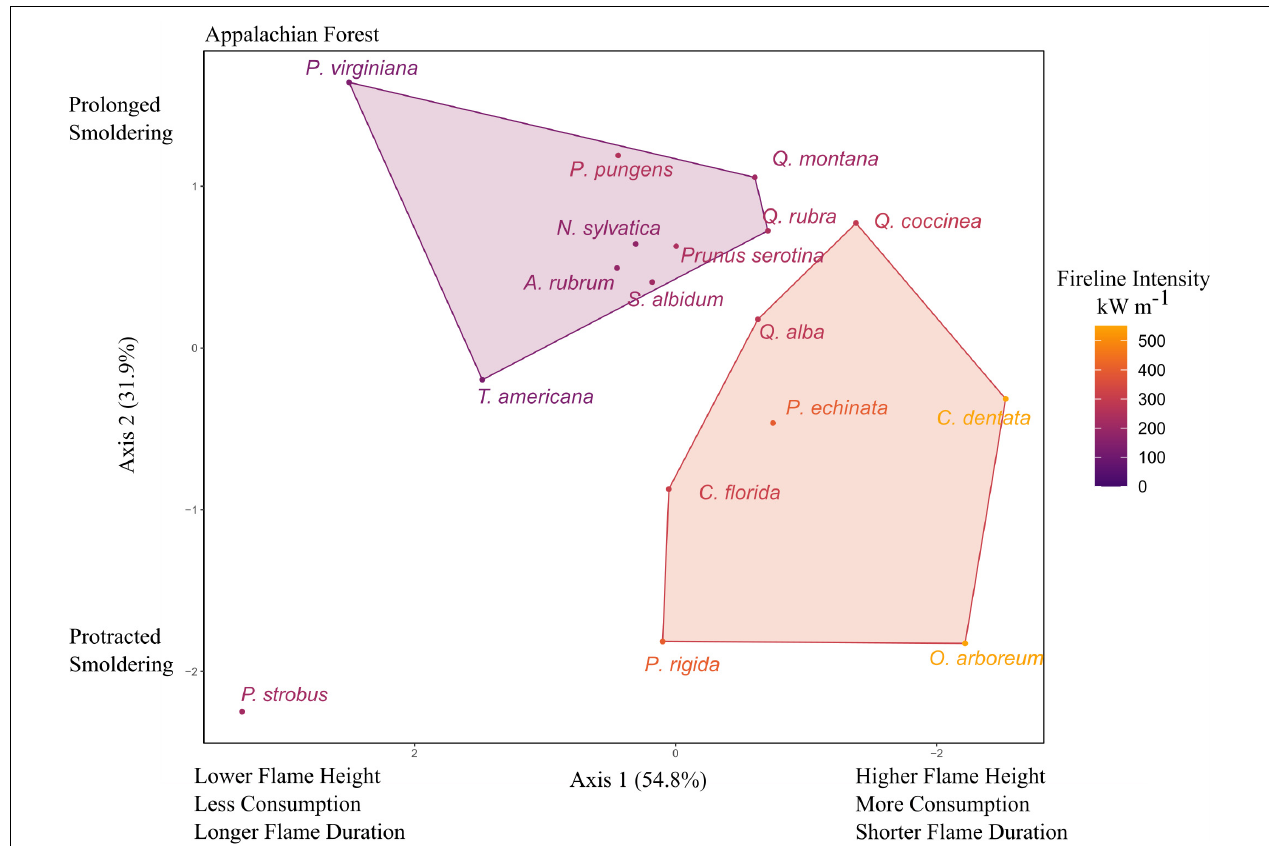
FIGURE 4 | Principal components analysis (PCA) for flammability of tree litter in Appalachian forests of the southeastern United States. Axis 1 was inverted to be consistent with the other figures (increased flame height and consumption on the right). Species codes and mean values listed in Table 1 and Supplementary Table 1